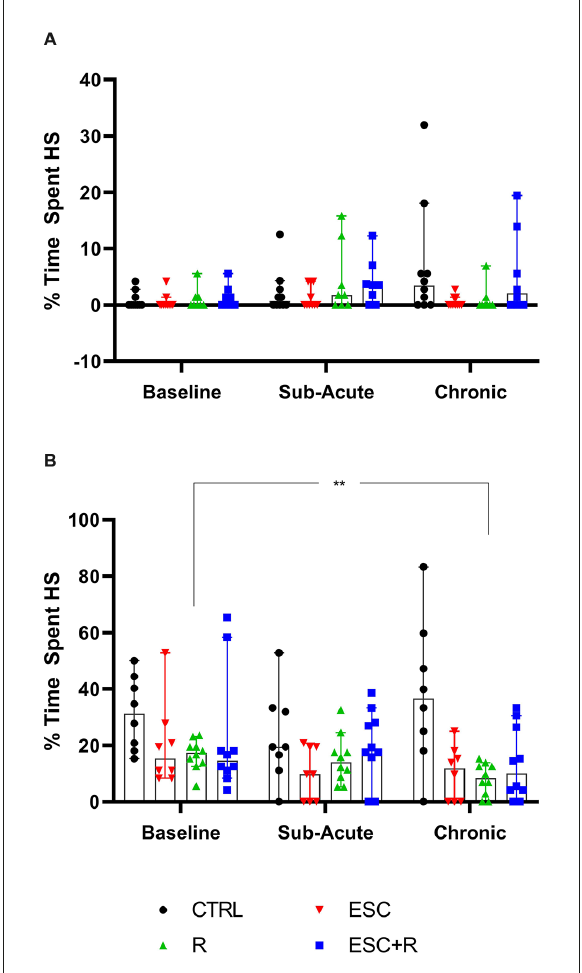
FIGURE6 Average time spent engaging in HS behavior at the chronic phase by (A) NS and (B) HS animals exposed to CTRL, R, ESC, and ESC+R. 2-way RM ANOVA followed by Bonferroni’s multiple comparisons tests. Data represent the median ± 95CI. CTRL, control (drug- and restriction-naïve animals); R, behavioral restriction; ESC, escitalopram; ESC+R, escitalopram combined with behavioral restriction. ** p <